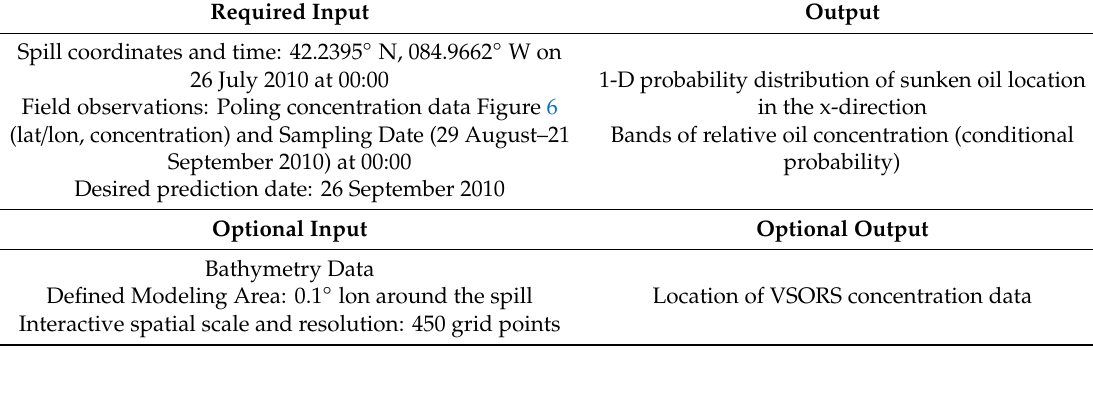
Table 4. Inputs and outputs for demonstration of Enbridge Kalamazoo River oil spill.